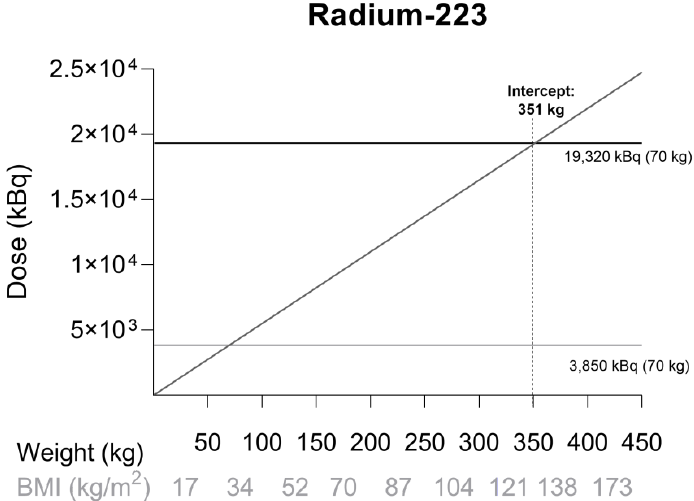
Figure 1. Dose simulation for radium-223 ( 223 Ra) at 55 kBq/kg. The gray horizontal line represents the registered dose for a 70 kg patient (55 kBq/kg), while the black horizontal line represents the maximum tolerated dose for a 70 kg patient (276 kBq/kg). The BMI was calculated for a patient with average height (1.70 m). The intercept at 351 kg shows the weight at which the registered dose is equal to the maximum tolerated dose when administered to a 70 kg patient. This corresponds to a patient with a BMI of 121 kg/m 2 .